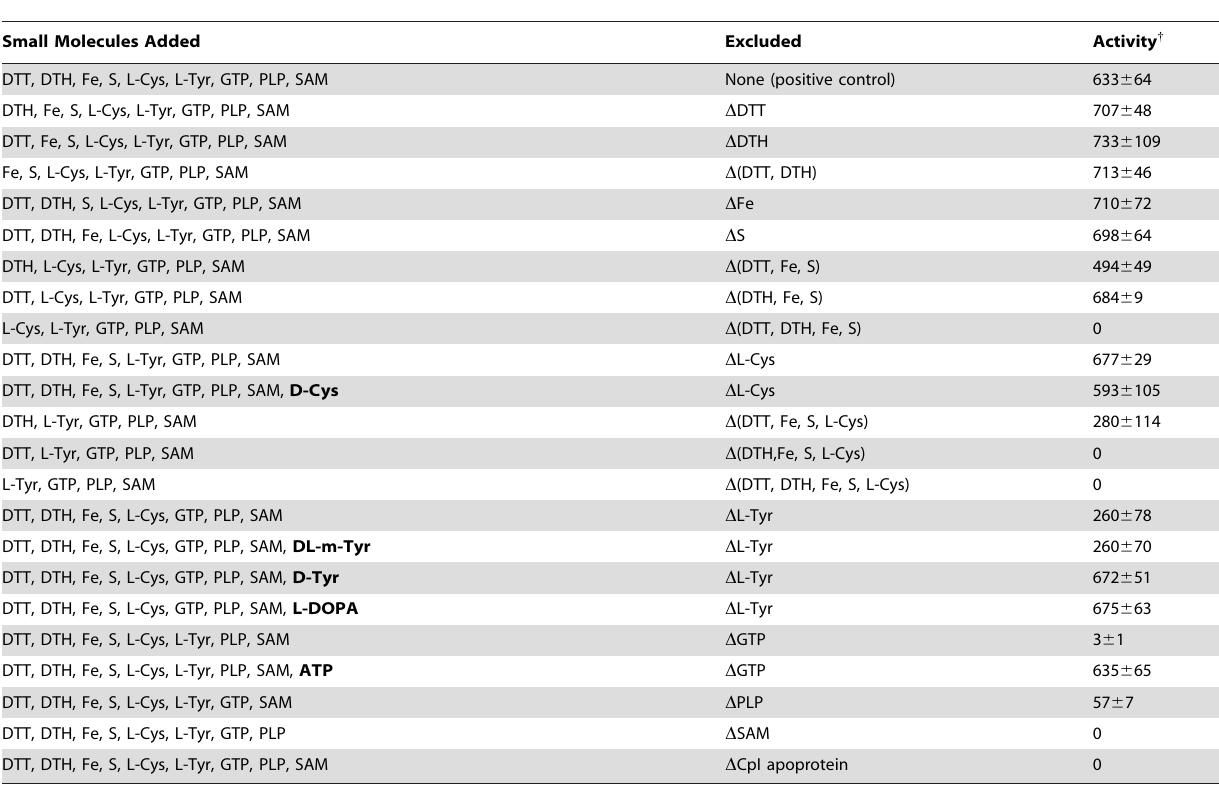
Table 1. Effects of exogenous substrates on in vitro hydrogenase activation.